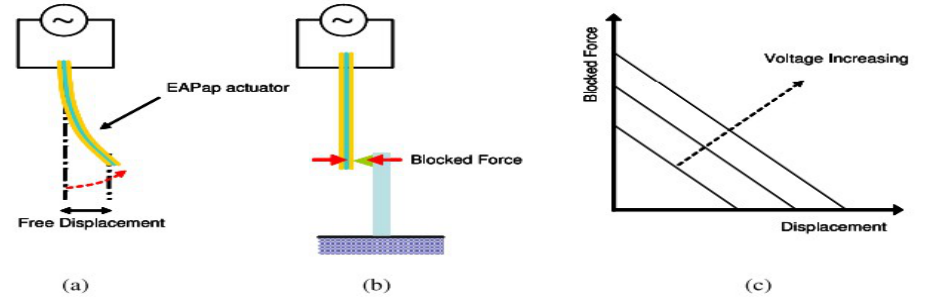
Figure 10. Schematic diagram of performance parameters: ( a ) free displacement, ( b ) blocked force, ( c ) force–displacement relation with increasing voltage [52].